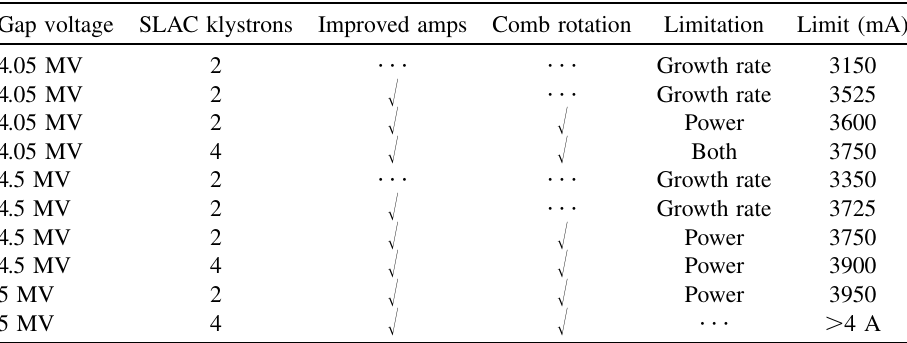
TABLE I. LER limiting factors and maximum current for each configuration. The (cid:1) mark signifies the applied upgrades in each configuration whereas the SLAC klystrons column shows how many of the four LER stations have SLAC klystrons installed (2 SLAC klystrons at the end of PEP-II operations).